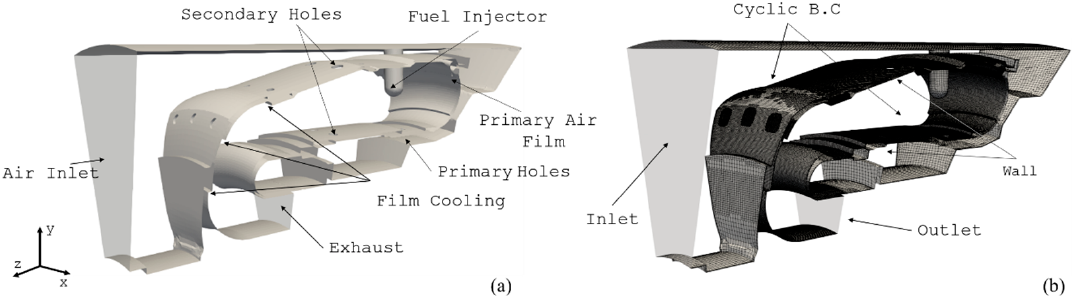
Figure 14. ( a ) Combustor components and ( b ) projection of the baseline grid on the combustor liner.